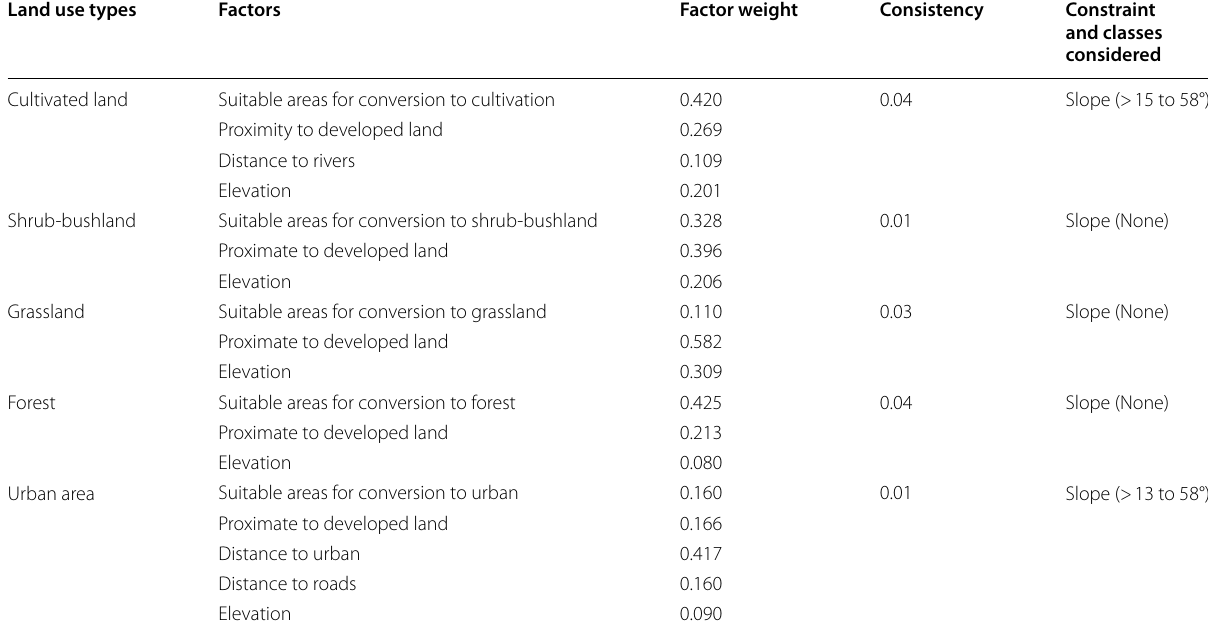
Table 3 Factors and constraints considered and their weights for predicting LULC conditions in Muga watershed